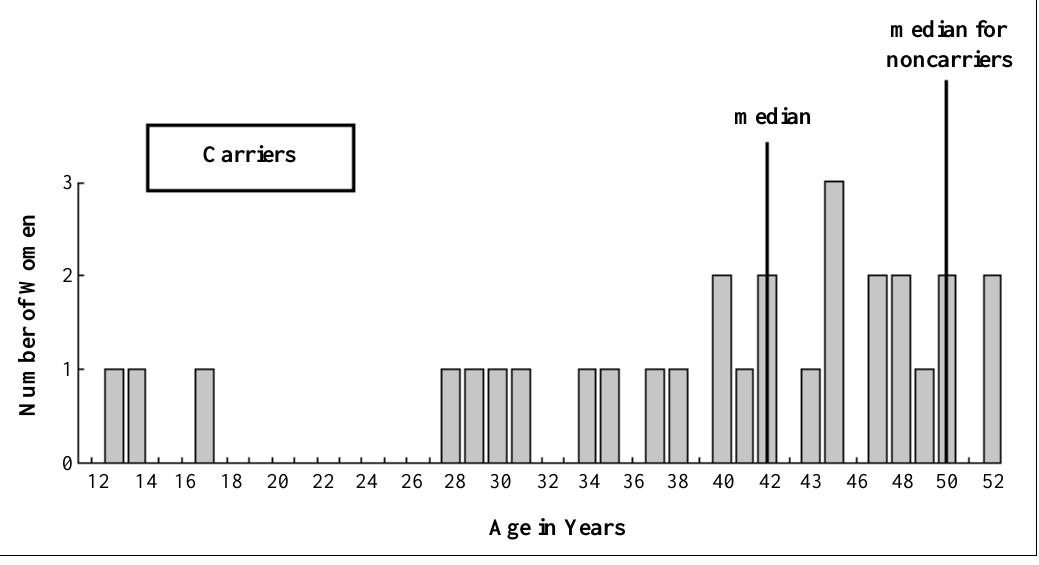
Figure 1 - Distribution of carriers of the fragile X premutation according to age at menopause. The difference between their median age at menopause and that of noncarriers indicates that premutated women are prone to early